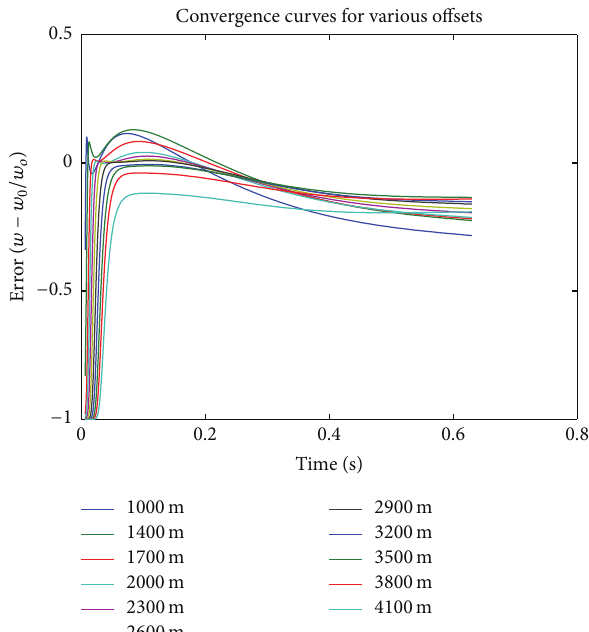
Figure 7: Convergence of the FDTD-computed MTEM earth impulse response error versus time for 2D homogeneous medium with 𝜌 = 10 Ω